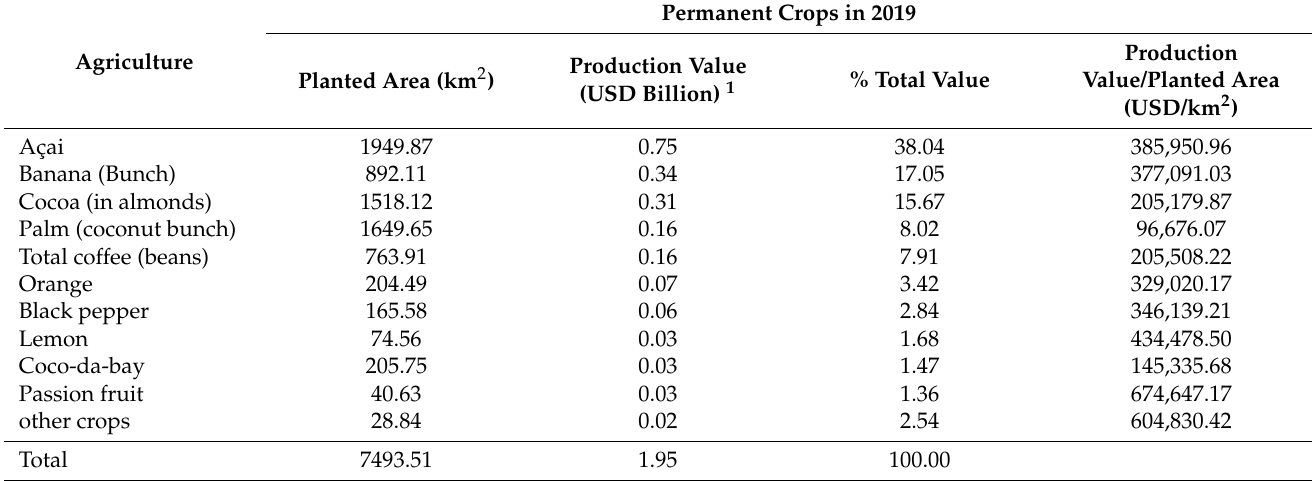
Table 7. Planted area (km 2 ) and production value (USD billion) of permanent crops in the Brazilian Amazon in 2019. Source: [21].